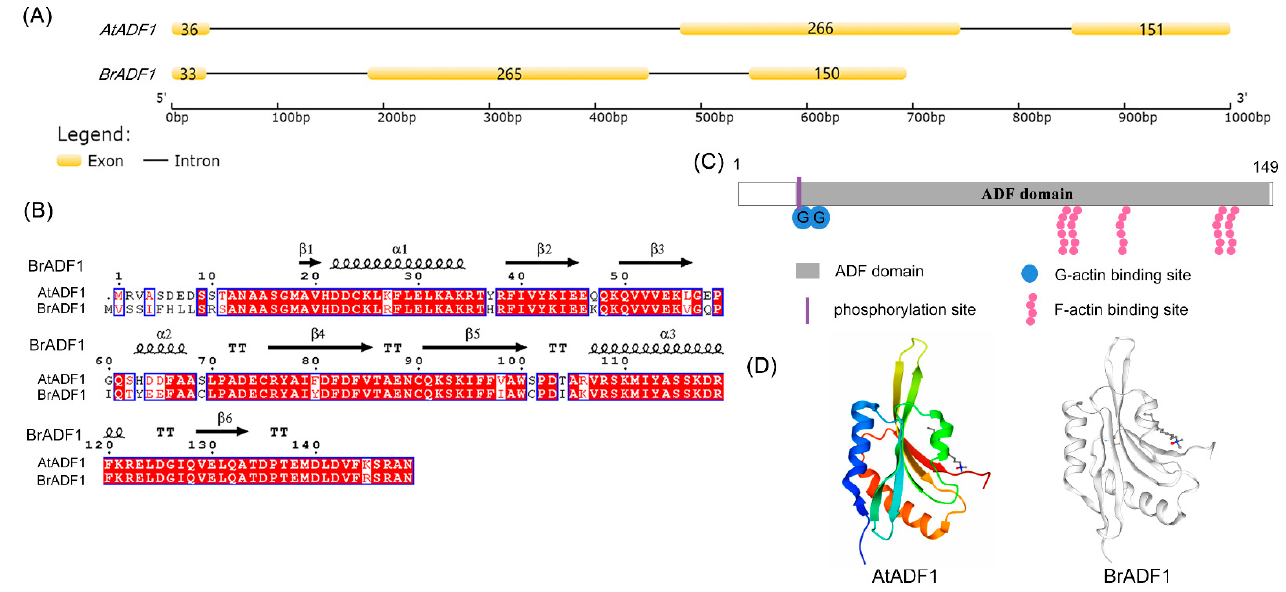
Figure 4. Sequence and structure analysis of Chinese cabbage ADF1 (BrADF1). ( A ) Gene structure alignment of AtADF1 and BrADF1 . Gene structures contain three exons and two introns in AtADF1 and BrADF1 . ( B ) Protein sequence alignment of AtADF1 and BrADF1. The top is the predicted secondary structure of protein BrADF1. ( C ) Predicted domain architecture of BrADF1. The BrADF1 coding sequence encodes 150 amino acids containing one ADF domain (amino acids 16–149), one phosphorylation site (amino acid 10), two G-actin binding sites (amino acids 16 and 17), and five F-actin binding sites (amino acids 92, 94, 108, 135, and 138). ( D ) Predicted tertiary structure of BrADF1, which is similar to the tertiary structure model 1F7S of